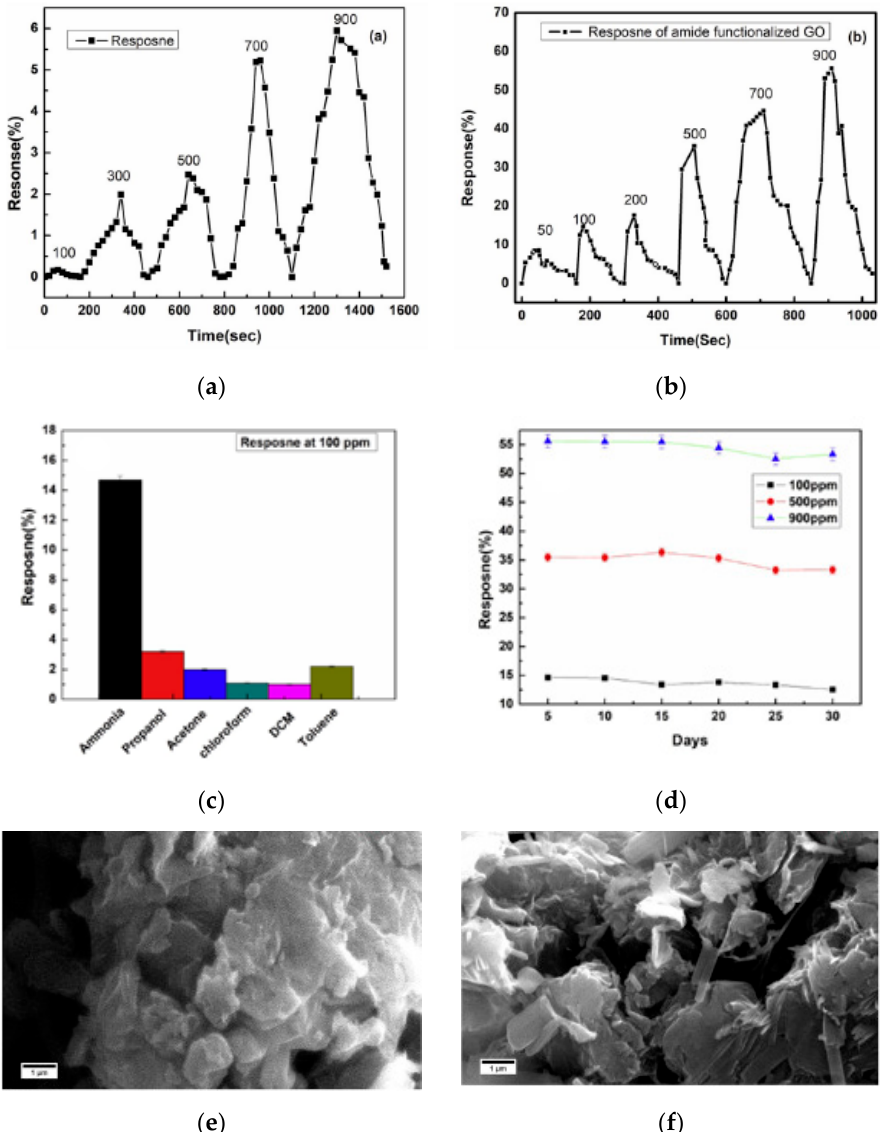
Figure 8. Response curves of ( a ) graphene oxide (GO) and ( b ) Amide functionalized GO; ( c ) Selectivity (concentration of gases was 100 ppm) and ( d ) Long-term response change of sensor based on functionalized GO; ( e ) SEM images of GO and ( f ) amide functionalized GO [169]. With the permission of Elsevier.